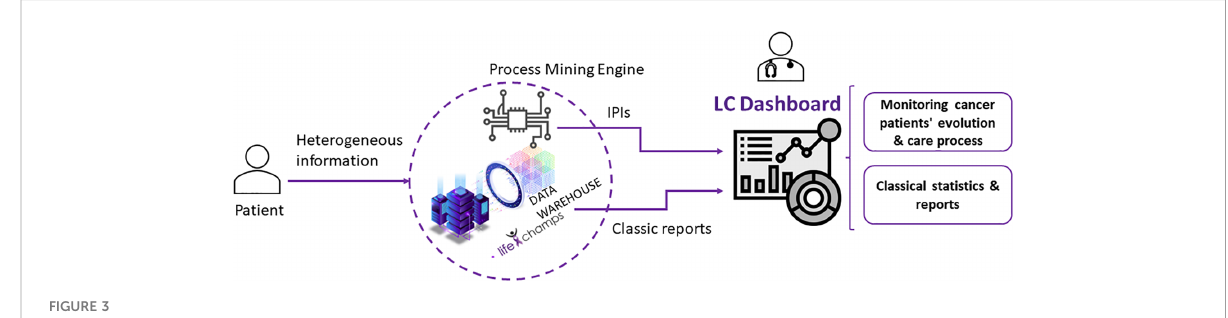
FIGURE 3 Dashboard logical